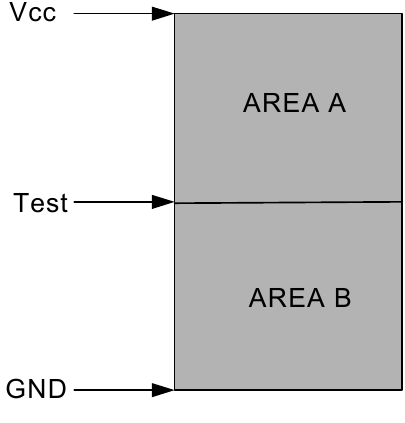
Figure 10. Measuring